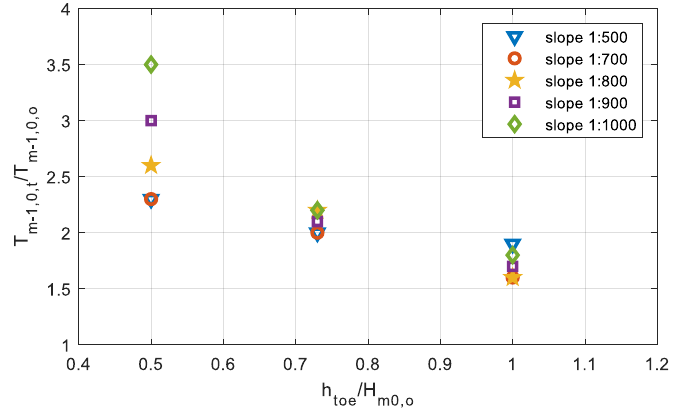
Figure 8. Calculated evolution of spectral wave period T m − 1,0,t as a function of water depth, offshore wave height and period.